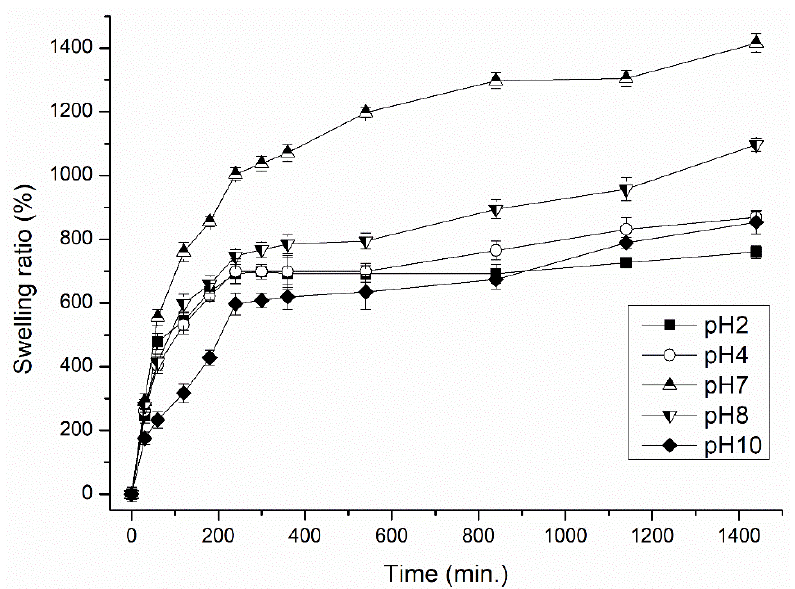
Figure 2. Effect of acidic (pH 2 and 4), neutral (pH 7) and saline (pH 8 and 10) swelling media on swelling behavior (SR %) by hydrogel H5CA within 24 h of swelling. Data refer to the mean value ± SD (n = 3).